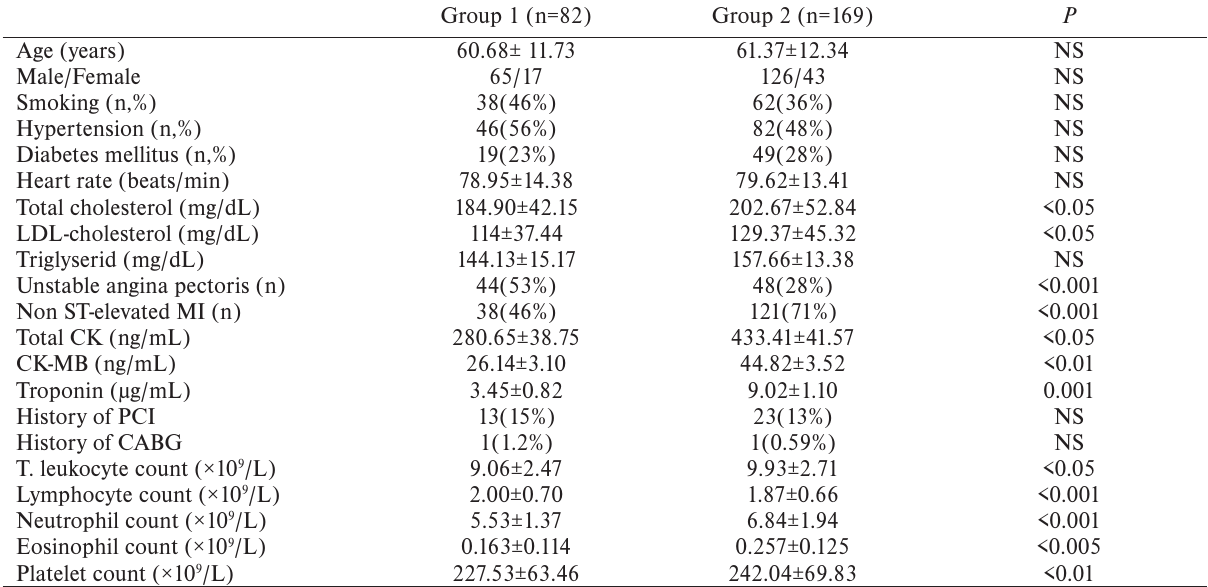
Table 1. The baseline characteristics of the study